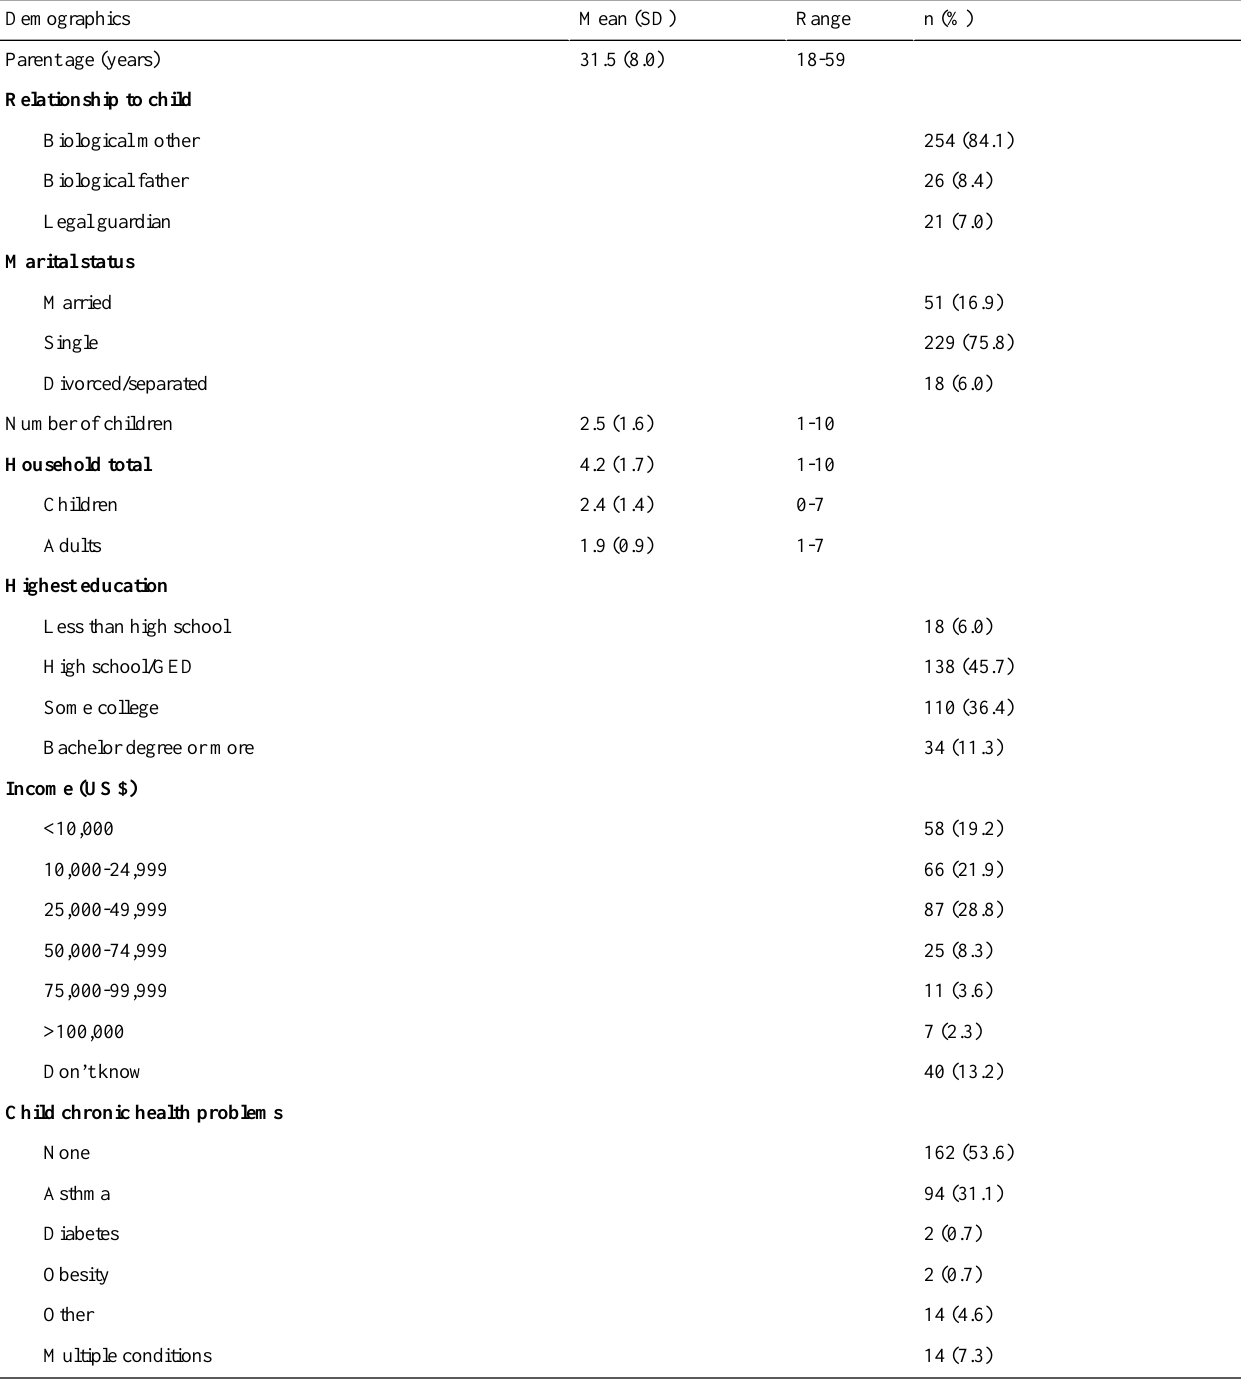
Table 1. Demographic characteristics of African American participants